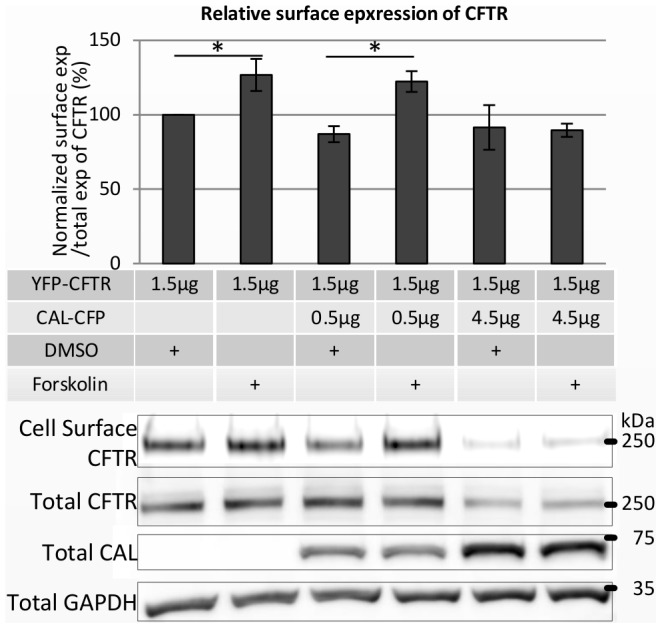
Forskolin fails to increase the cell-surface expression of CFTR with highly overexpressed CAL.HeLa cells were transfected with YFP-CFTR and CAL-CFP as indicated in the table. At 48 hours after transfection, cells were treated with DMSO or 100 µM forskolin at 37°C for 30 minutes. CFTR at the cell surface was then biotinylated. Cell surface-biotinylated CFTR, total CFTR, and total CAL were immunoblotted with anti-GFP antibody, and GAPDH was immunoblotted with anti-GAPDH antibody. The graph shows the ratio of the cell surface-biontinylated CFTR expression level to the total CFTR expression level, normalized by the ratio of the YFP-CFTR-alone samples with the DMSO treatment (%). When CAL was not overexpressed or 0.5 µg of CAL was transfected, forskolin increased the cell-surface expression of CFTR. However, when 4.5 µg of CAL was transfected, forskolin did not increase the cell-surface expression of CFTR. The total expression of CFTR was not altered by the forskolin treatment in all cases. Results are means ±SE. (n = 4) *p<0.05.